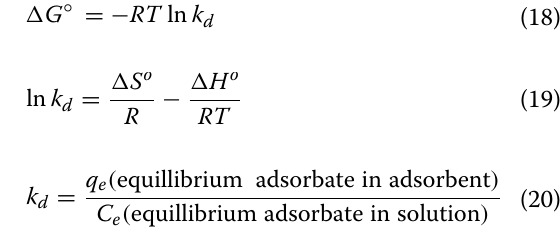
Table 3 Thermodynamic parameters of studied phenolic compounds onto Fe